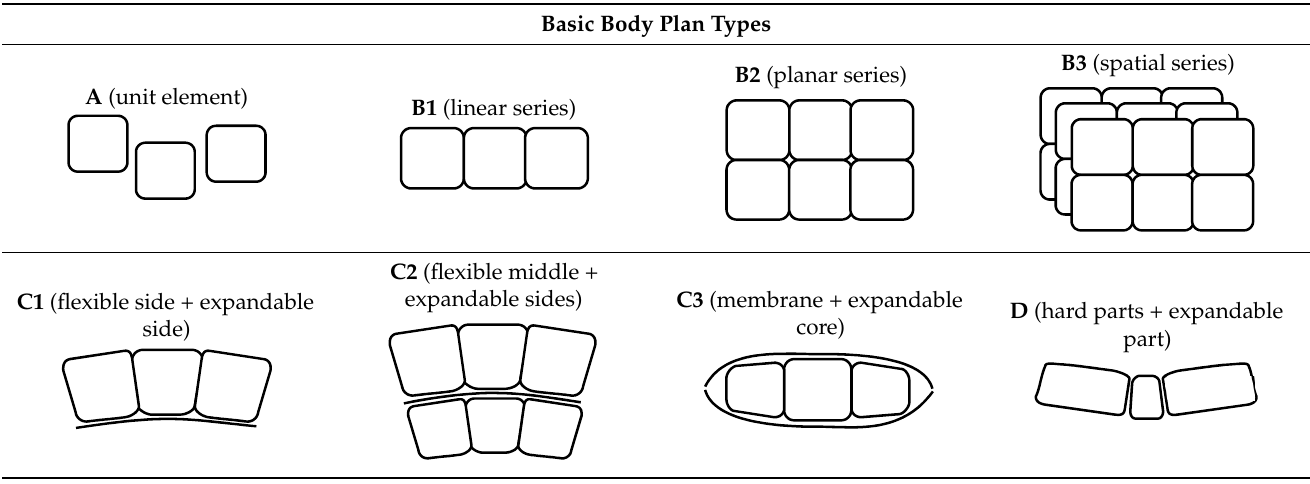
Table 1. Basic body plan types with short description and scheme adapted from [29].